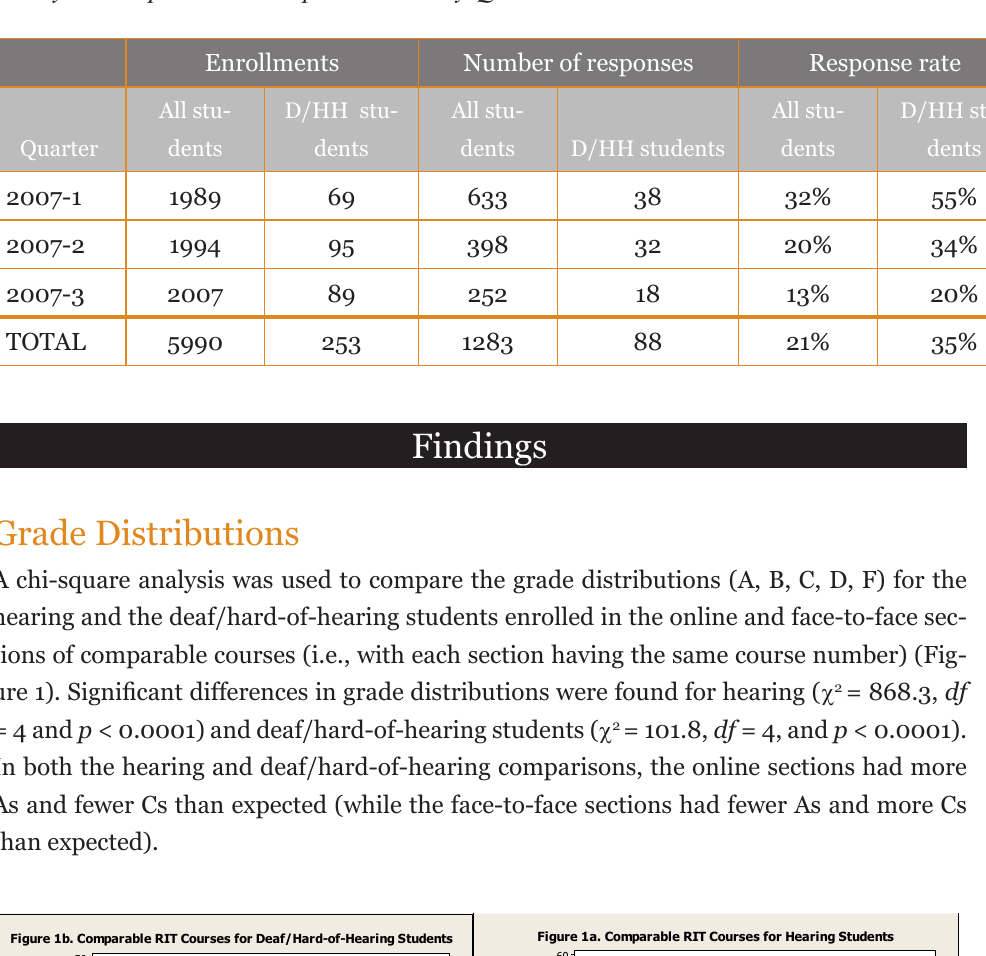
Figure 1b. Comparable RIT Courses for Deaf/Hard-of-Hearing Students Figure 1a. Comparable RIT Courses for Hearing Students